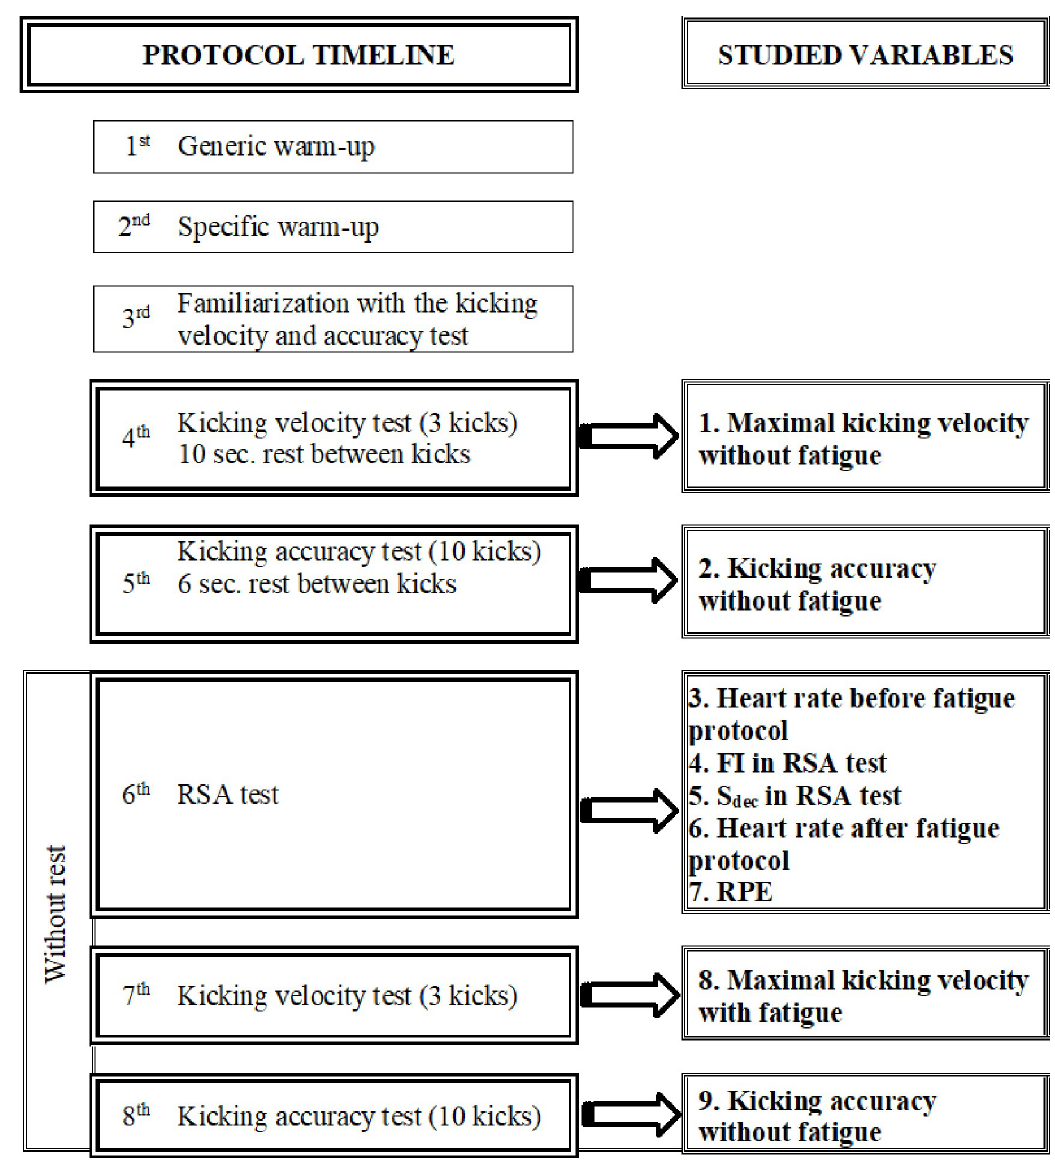
Fig 1. Timetable and variables